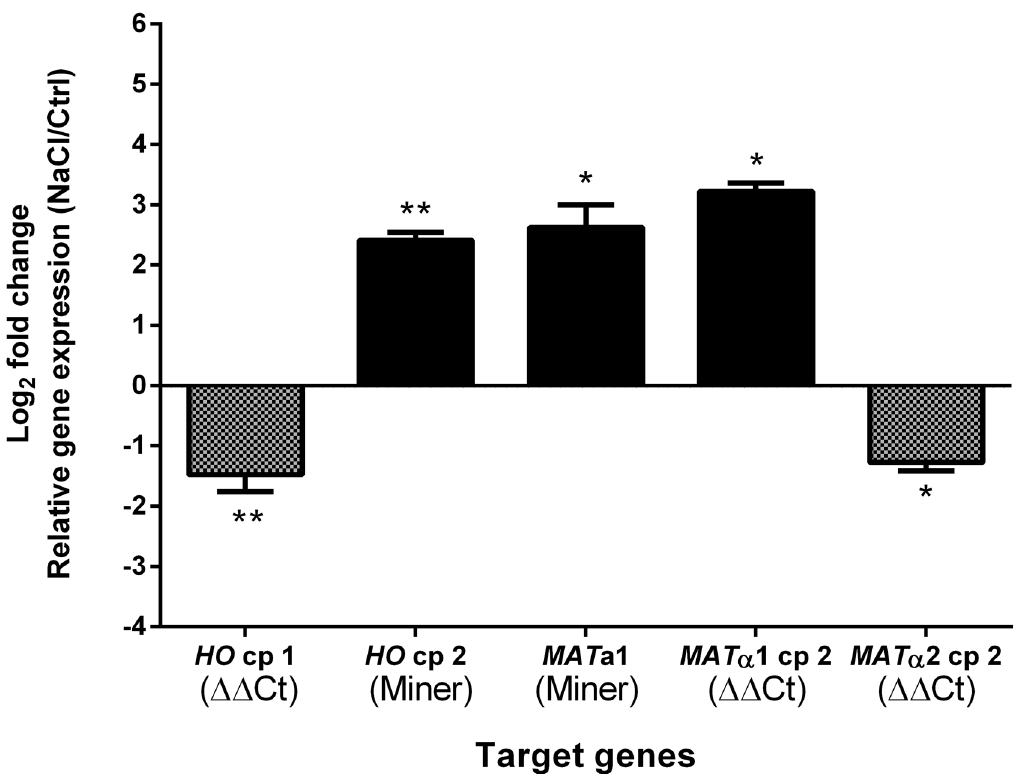
Fig 8. Differential expression by quantitative real-time PCR of mating-type and HO genes in ATCC 42981 cells after hyperosmotic stress. Expression of target genes was normalized on the reference ZrACT1 (GenBank: XM002497273). Fold change was measured by ΔΔ Ct or PCR Miner methods and reported as the mean ( ± SEM) of three biological replicates. * indicates significant difference from controls as measured by independent Student's t -tests ( * P < 0.05, ** P < 0.01).